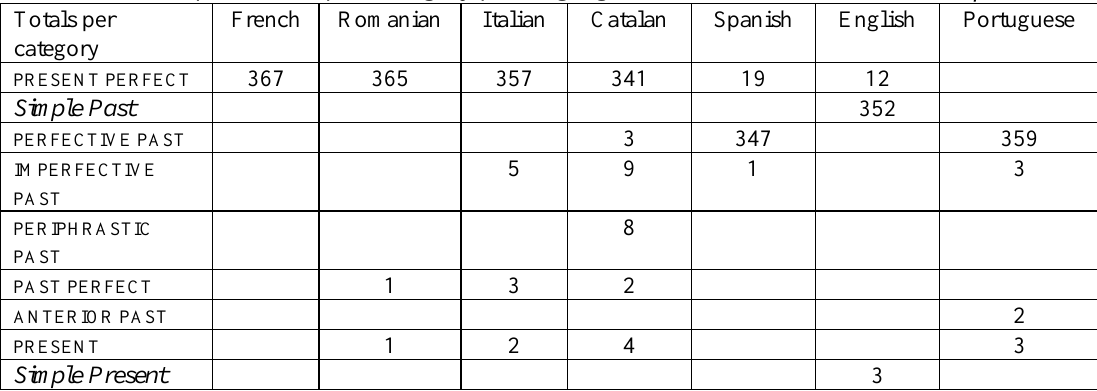
Table 1 . Totals per tense-aspect category per language as translation of the Passé Composé Totals